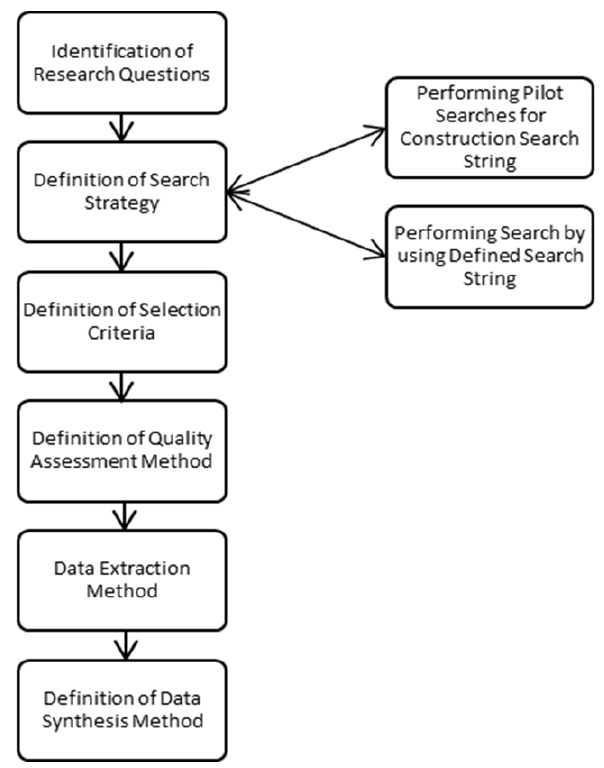
Figure 1. Adopted systematic literature review protocol .